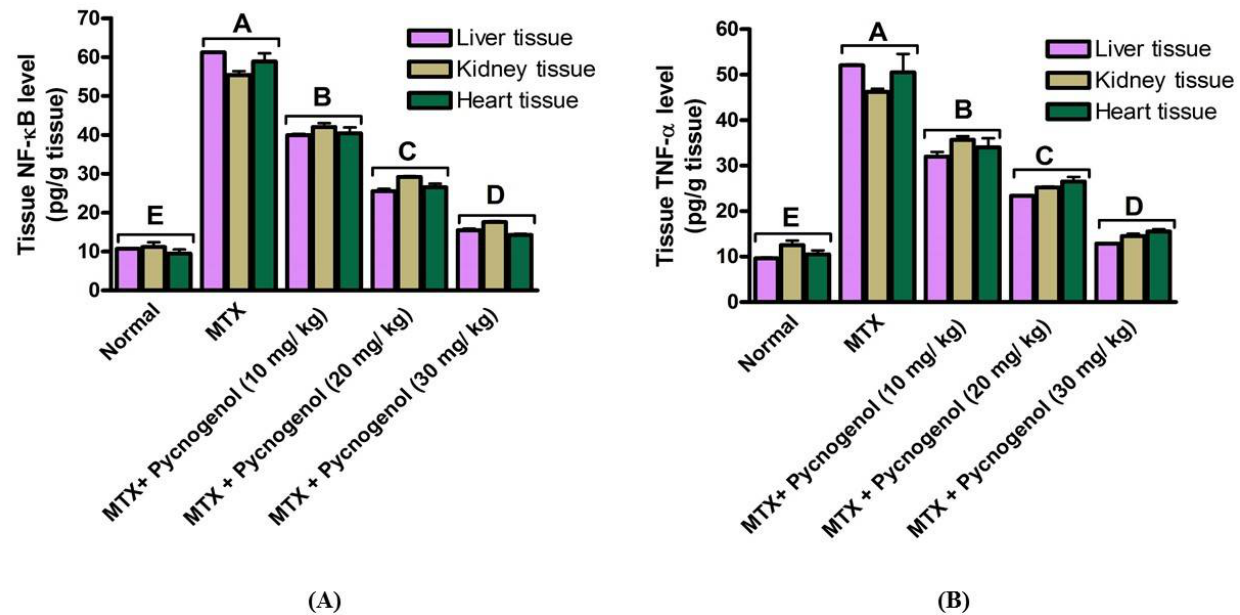
Figure 2. Effect of MTX and pycnogenol on ( A ) NF-κB and ( B ) TNF-α, the inflammatory biomarkers. NF-κB: nuclear factor-κB; TNF-α: tumor necrosis factor-α, p < 0.05. Bars represent the mean value and the standard error for means. Bars with different letters are significantly different according to DMRTs at p = 0.05.